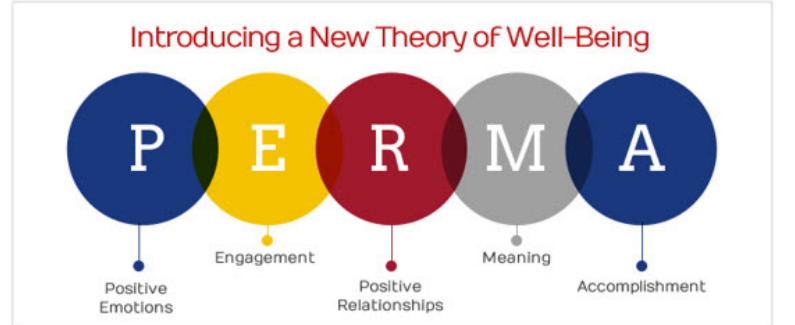
Figure 1. The five pillars of the PERMA Model (Martin Seligman,